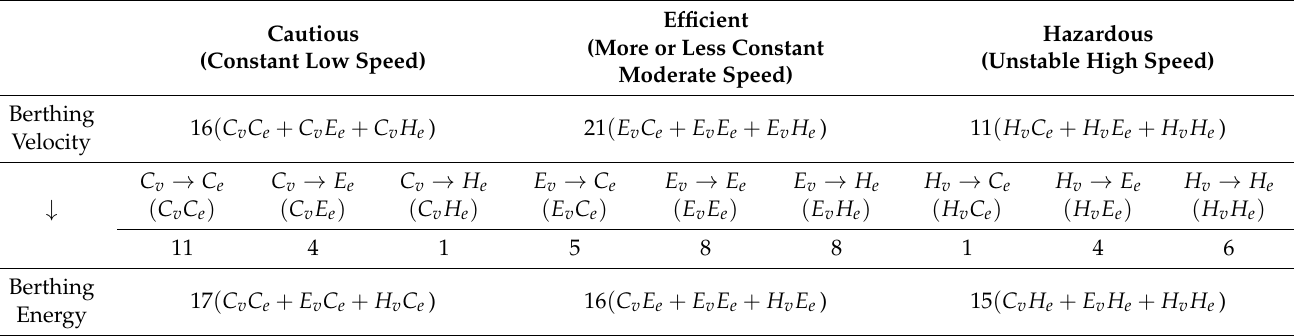
Table 7. Pilots’ movement according to each variable.